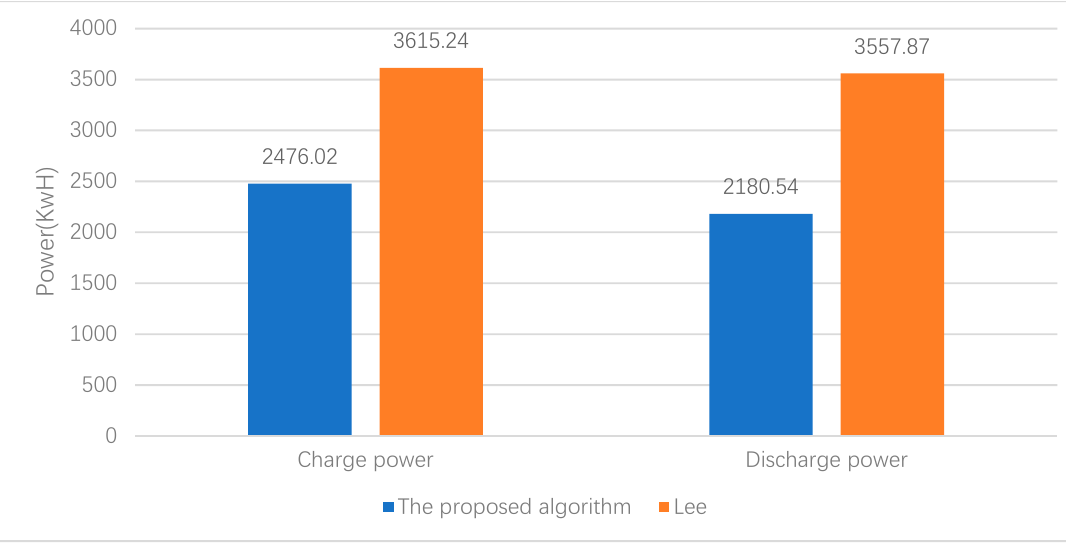
Figure 14. Total charge and discharge power comparison.